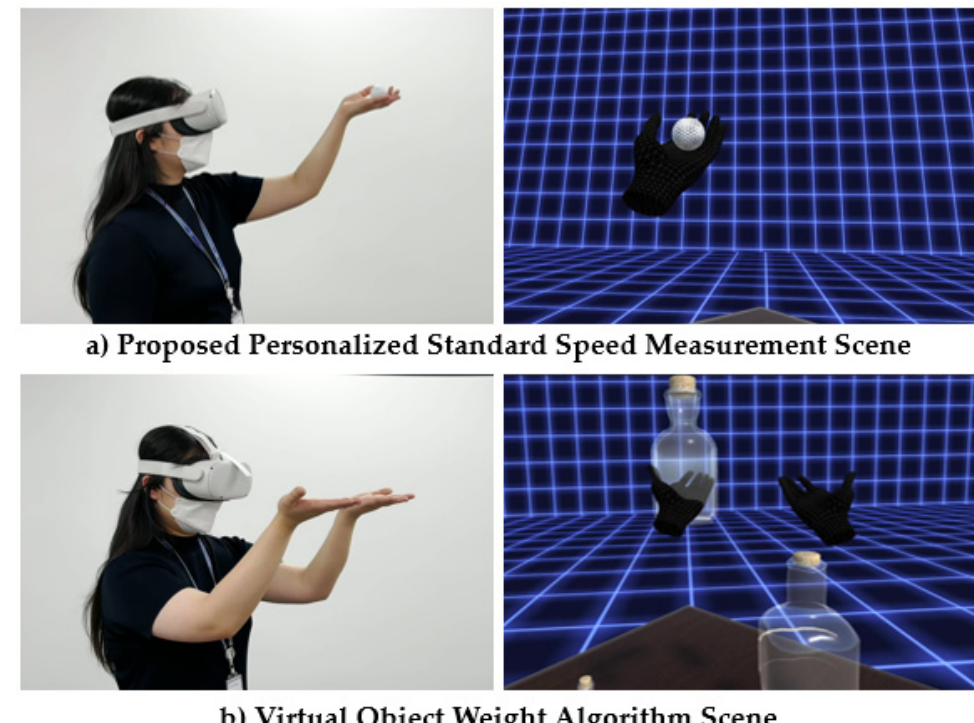
Figure 6. Simulation scene based on virtual object weight algorithm. ( a ) Because the user feels a different individual weight depending on the experience and degree of immersion in VR, the user lifts a golf ball in the real space and measures this speed to define it as a customized standard speed, ( b ) Virtual Object Weight Algorithm.